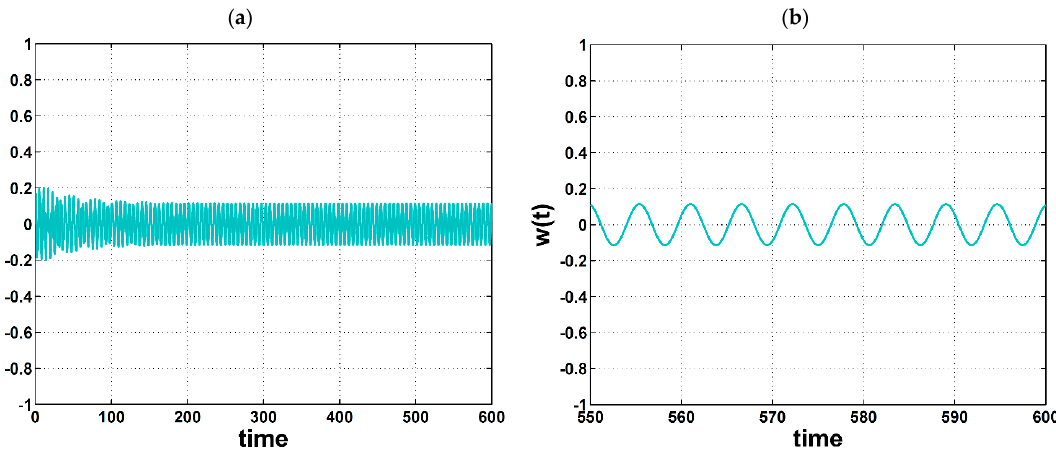
Figure 14. The time history of the car post-control ( k p = 0.8 and k v = 0) at ω = 1.12, k = 7, β = 0.8, and ζ = 0.02: ( a ) total trace for 600 s and ( b ) last 50 s of the total trace.